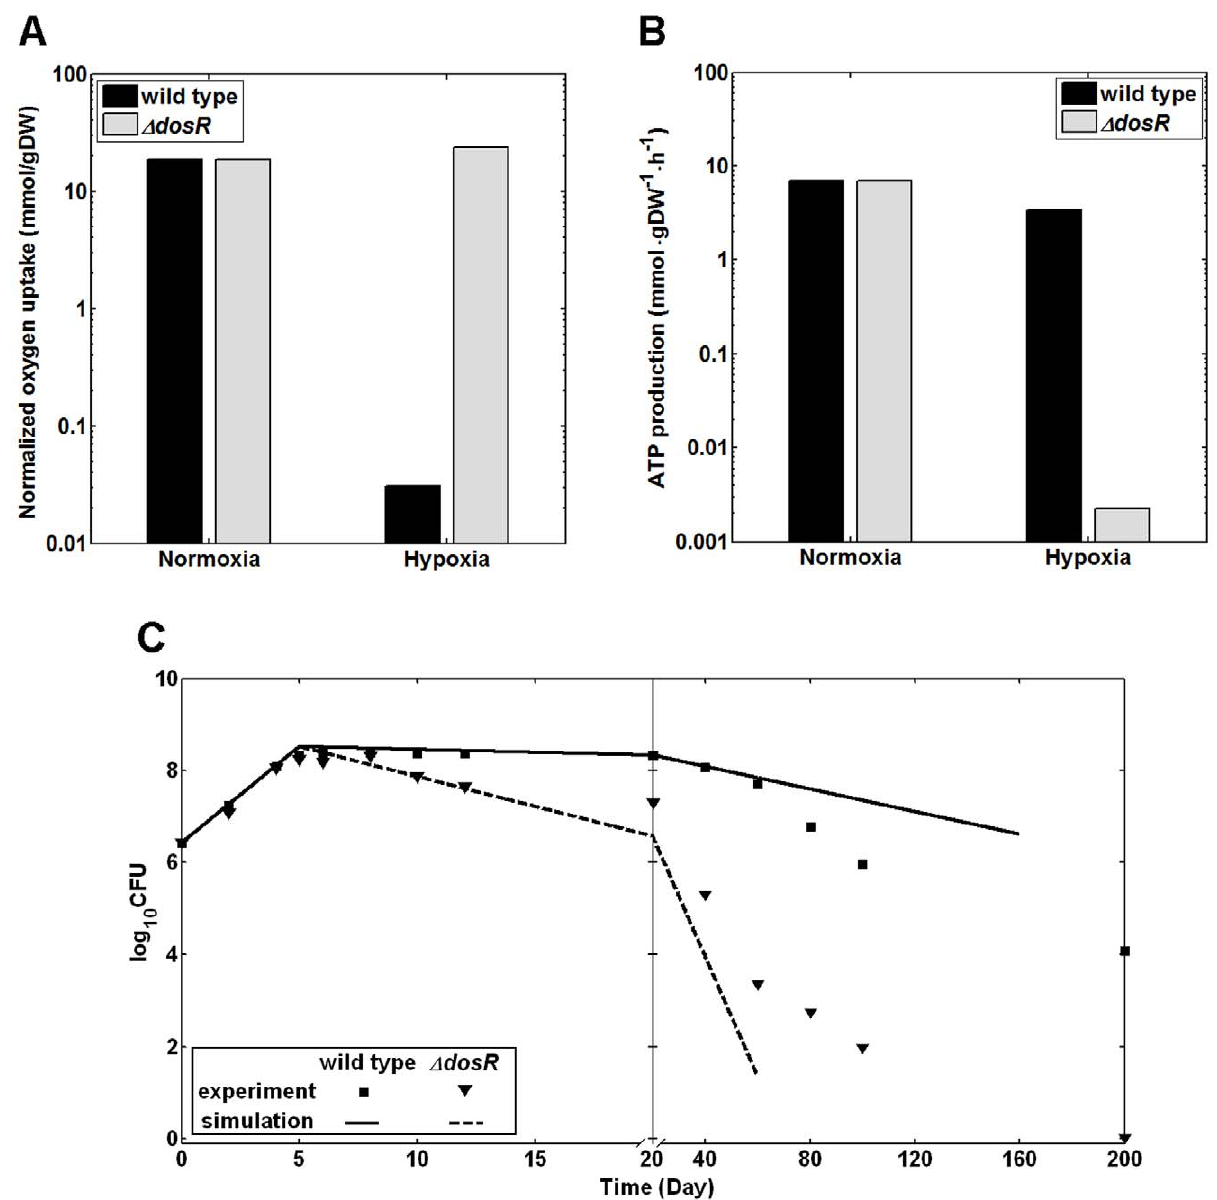
Figure 2. Phenotypic characteristics of wild type Mycobacteriumtuberculosis H37Rv and D dosR under normoxia and hypoxia. (A) The predicted normalized oxygen uptake rates of Mycobacterium tuberculosis H37Rv and the D dosR deletion mutant under normoxia and hypoxia. The oxygen uptake rates were normalized by each strain’s biomass production rate. Supplemental Table S1 gives the biomass production rates of each strain under different conditions, which were calculated as described in the Materials and Methods Section. We based the metabolic network models of the hypoxic state on differential gene expression data associated with the change from normoxic air to hypoxic nitrogen gas with 0.2% oxygen (1.5 mm Hg) after 2 hours [25]. The wild type metabolic response involved reducing its oxygen requirement to cope with the low-oxygen stress, while the D dosR deletion mutant was not capable of adjusting. (B) The predicted ATP production levels for the same systems as in panel A showed a slight reduction for the wild type and a much larger decrease for the D dosR deletion mutant in response to hypoxia. Note that the ATP production rates were not normalized so to facilitate a direct comparison with the experimental data in Refs. [16] and [49]. (C) The modeled growth characteristic of the wild type and D dosR deletion mutant were compared with the corresponding experimental data [49]. Following the experimental data presentation, the x-axis plots two different time intervals, 0–20 and 20–200 days, using two different time scales. The initial aerobic growth phase for the first 5 days was followed by a slight decrease in cell concentration upon switching to hypoxic conditions on day 5. Our metabolic model interpretation was also compatible with a slight decrease in cell concentration for wild type and a substantial decrease for the deletion mutant. Because the gene expression data was compatible with the immediate hypoxic response, the validity range of the metabolic model cannot be expected to capture genotypic and phenotypic adaptations beyond an initial adaptation. Here, the calculated growth reductions for the wild type and D dosR deletion mutant mimicked the experimental data up to days 60 and 12,